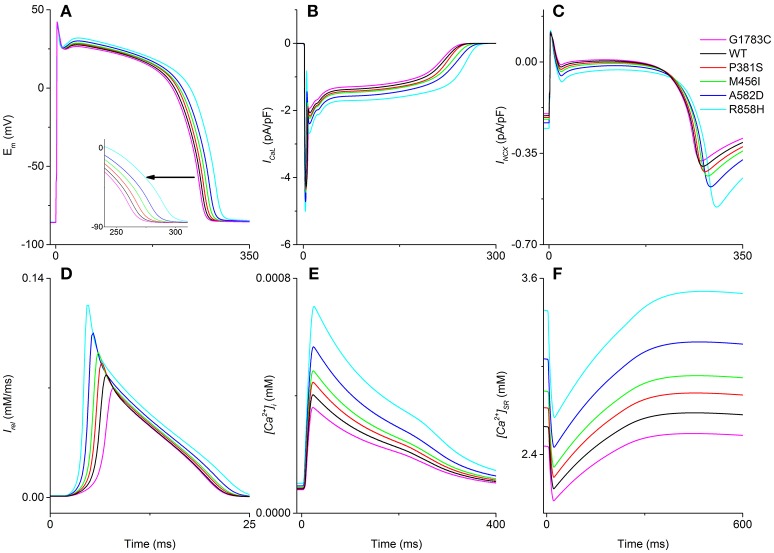
Intracellular calcium handling and action potential. For endocardial cells, time courses of the membrane potential (Em, A), the L-type calcium current (ICaL, B), the sodium-calcium exchanger current (INCX, C), calcium induced calcium release flux (Irel, D), cytoplasmic calcium concentration ([Ca2+]i, E) and sarcoplasmic reticulum (SR) calcium concentration ([Ca2+]SR, F) in the G1783C (Magenta), wild-type (WT, Black), P381S (Red), M456I (Green), A582D (Blue), and R858H (Cyan) conditions are shown. The pacing cycle length (PCL) used in these simulations is 1,000 ms. Action potential duration, INCX, Irel, [Ca2+]i, and [Ca2+]SR augment with an increase in ICaL. Changes in action potential duration are indicated by an enlargement of the (A).